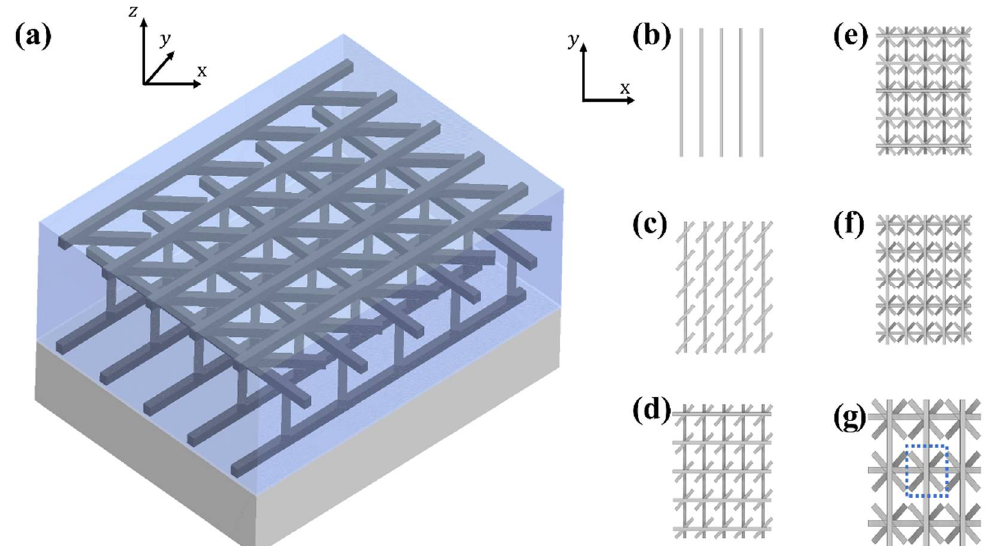
Figure 1. Nanostructures of the dichroic circular polarizer. ( a ) Overall structure in 3D view, showing the relative positions of the layers. Note: each layer is isolated with 30 nm SiO 2 ( b ) Top layer: Al nanograting aligned along the y -axis, ( c ) Second layer: Al nanocuboid array rotated 45 ◦ around the z -axis, ( d ) Third layer: Al nanograting rotated by 45 ◦ so it now aligns with the x -axis, ( e ) Fourth layer: Al nanocuboid array, again rotated 45 ◦ around z -axis, ( f ) Fifth layer: Al nanograting rotated and aligned along the y -axis, ( g ) Top view of the dichroic circular polarizer with the simulation unit shown within the blue dashed square.